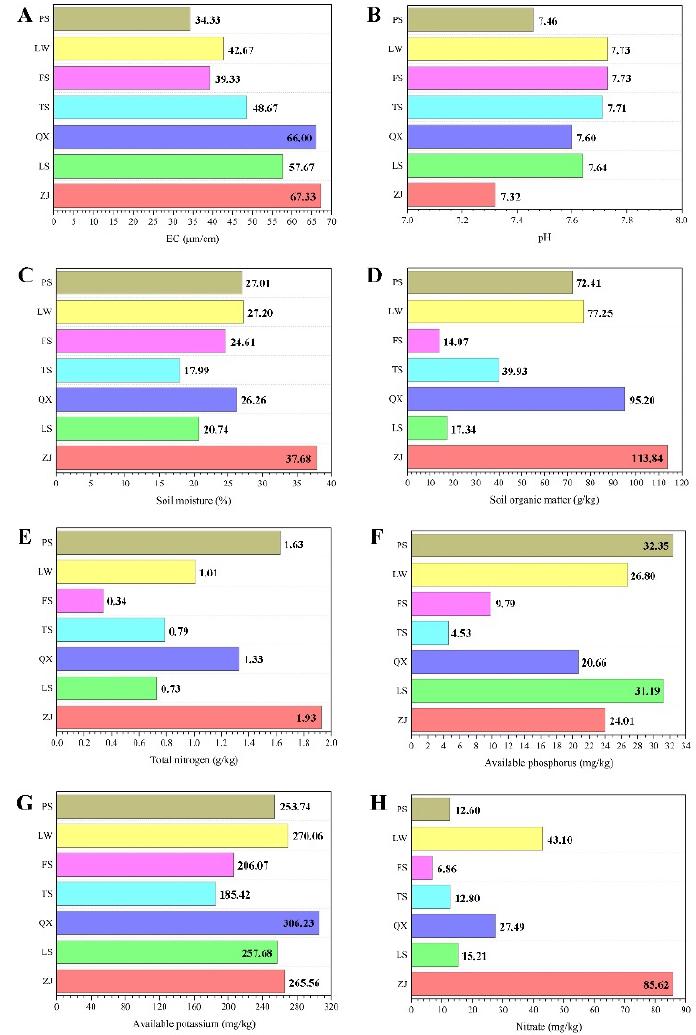
Figure 5. Average level of physical and chemical soil properties of the seven mountains. ( A ): The average level of EC. ( B ) The average level of pH. ( C ) The average level of Soil moisture. ( D ) The average level of Soil organic matter. ( E ) The average level of Total nitorgan. ( F ) The average level of Available phosphorus. ( G ) The average level of Available potassium. ( H ) The average level of Ni- trate.